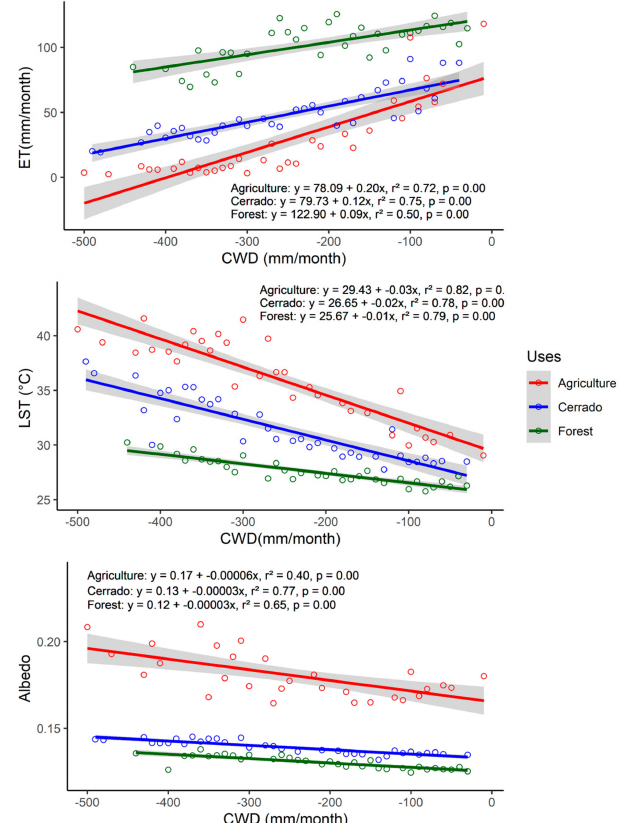
Figure 3. E ff ects of drought (cumulative water deficit (CWD)) on evapotranspiration (ET: top), land surface temperature (LST: middle), and albedo (bottom) within the Brazilian state of Mato Grosso. The shaded areas indicate the interquartile